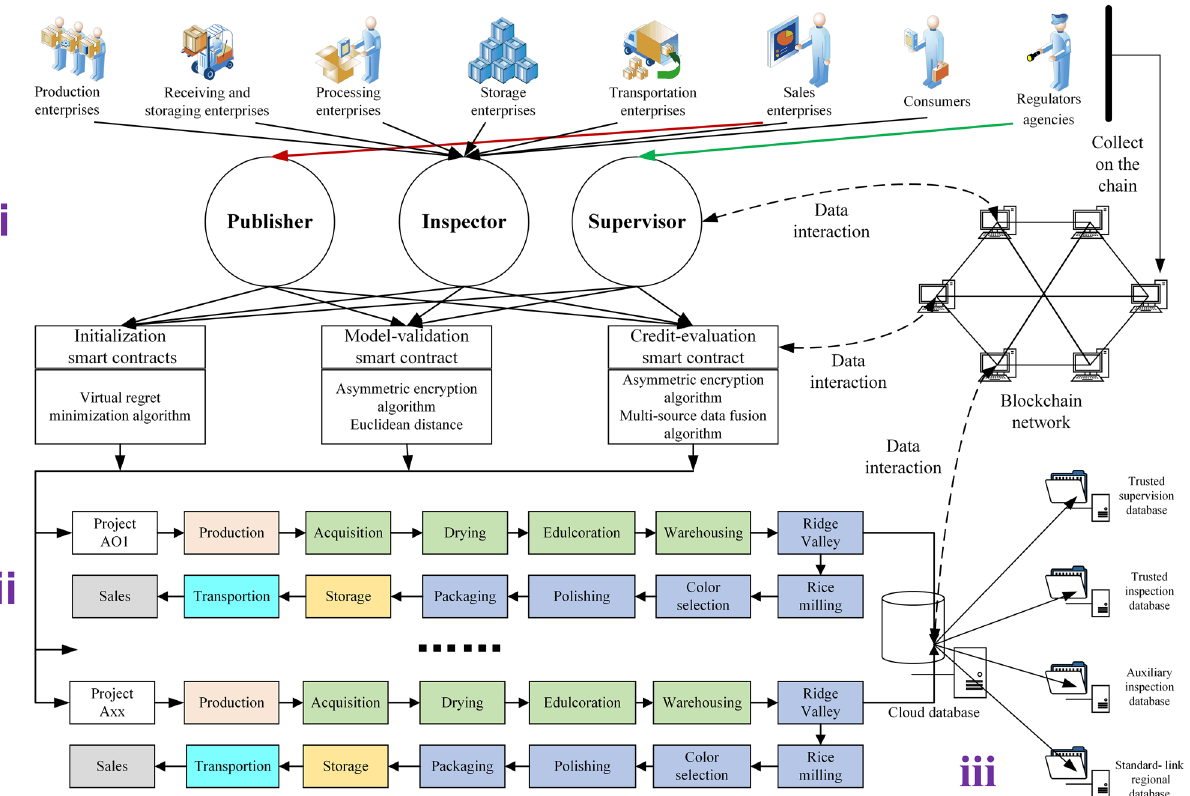
Figure 1. Dynamic supervision model for the rice supply